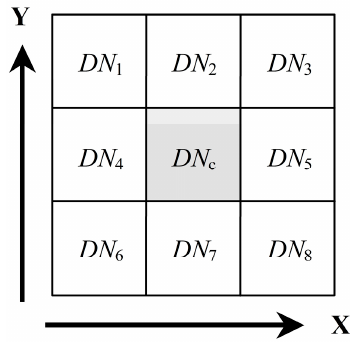
Figure 2. Schematic diagram of the calculation of the spatial brightness gradient. (Modified from Ma et al.